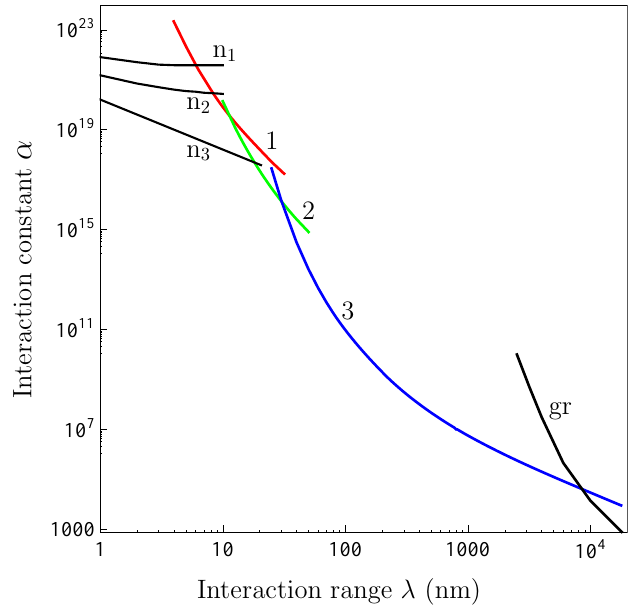
Figure 1. The constraints on the parameters of the Yukawa-type interaction obtained from the ex- periments on neutron scattering are shown by the lines labeled n 1 [17], n 2 [16] and n 3 [18]. The lines labeled 1, 2 and 3 show the constraints following from measuring the lateral [35–37] and nor- mal [38–40] Casimir forces between the sinusoidally corrugated surfaces and from the differential measurements where the Casimir force was nullified [30], respectively. The line labeled gr follows from the Cavendish-type experiments. The regions of the ( λ , α )-plane above each line are excluded and below each line are